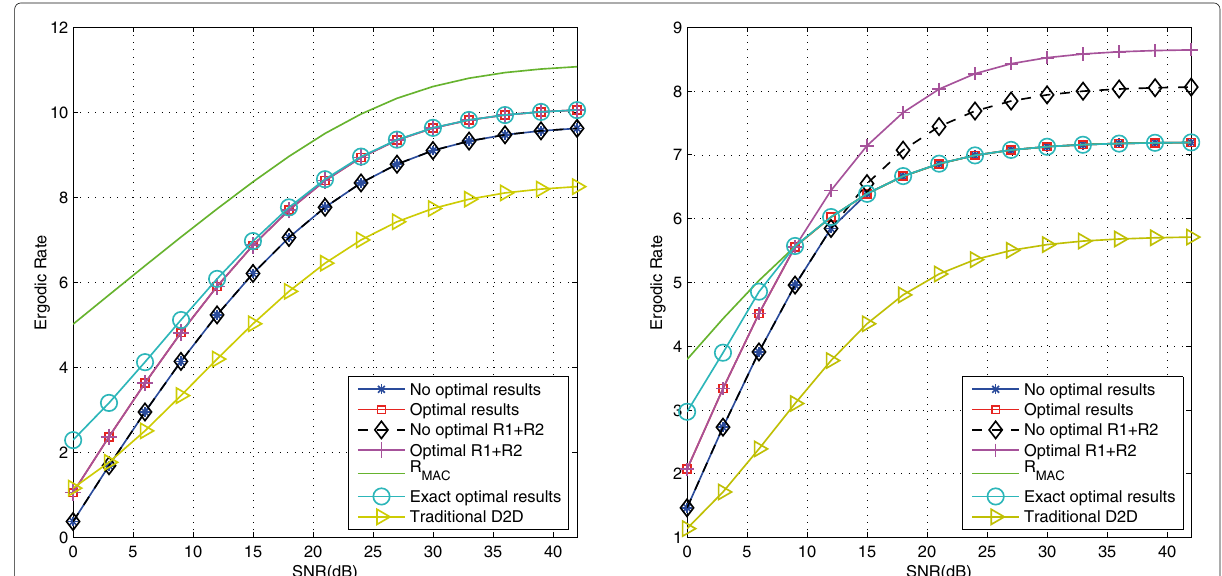
Fig. 6 Ergodic rate performance comparison of the proposed power allocation strategy against the SNR for different parameters of ) = ( 4,0.25,0.75 ) and ( d ) = ( 2,0.35,0.65 ) . The equal power allocation and traditional D2D communication results are ( d cr , d 1 r , d 2 r cr , d 1 r , d 2 r presented for